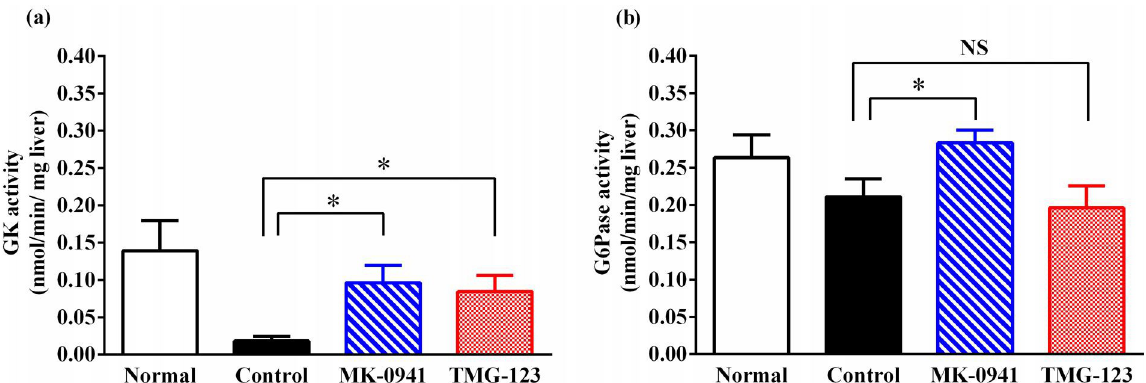
Fig 3. GK and G6Pase activity in the liver after 20-week treatment with GK activators. (a) GK activity and (b) G6Pase activity at week 20 of the chronic treatment study. Normal; Wistar rats, Control; Goto-Kakizaki rats fed normal diet, n = 7–8. � p < 0.05, NS = not significant.